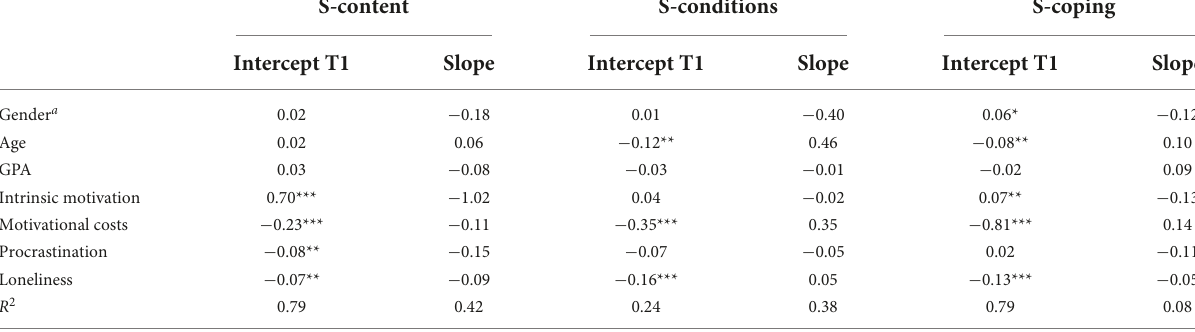
TABLE 6 Prediction of study satisfaction subdimensions at T1 and changes over time in Study 2 (standardized